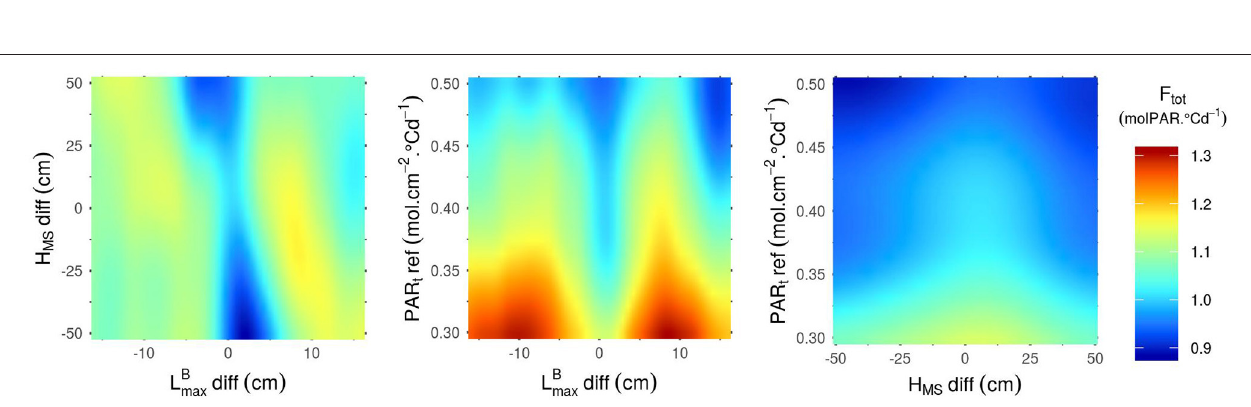
FIGURE 4 | F tot predicted by the Kriging metamodel as a function of the 3 parameters that have the most impact on the variance of this output ( L B max -diff, H MS -diff and PAR t -ref). Predictions were made with all other parameters set to their mean